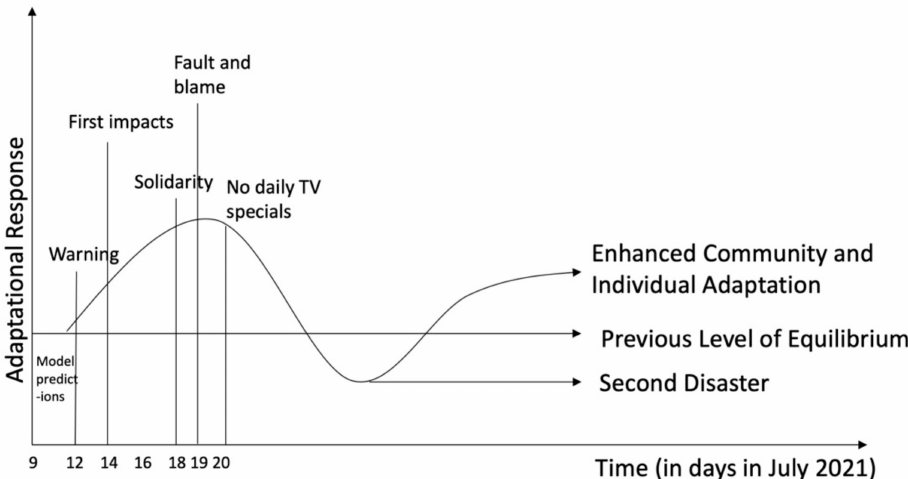
Figure 2. Time-phase of awareness and response to the 2021 flood in Germany, based on Raphael 1986, Erikson